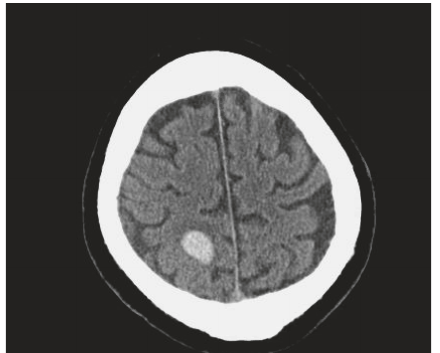
Figure 3: CT scan of the brain without contrast showing an acute 2.2 cm intraparenchymal hemorrhage with vasogenic edema in the posterior right parietal